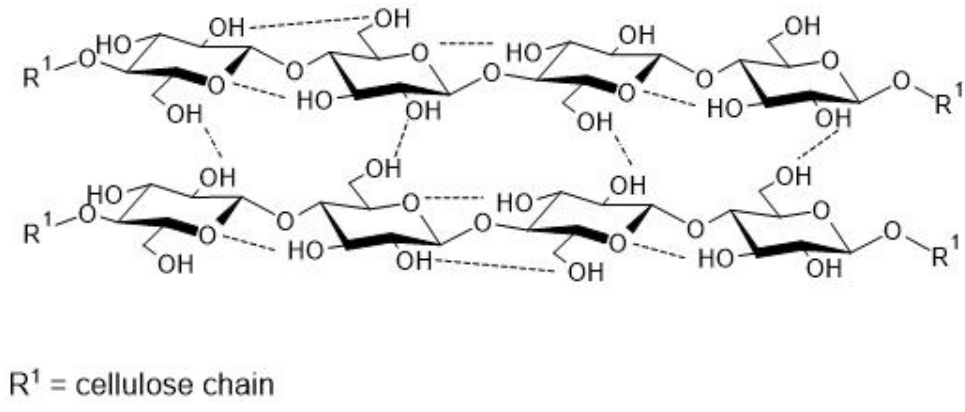
Figure 5. Partial structure of